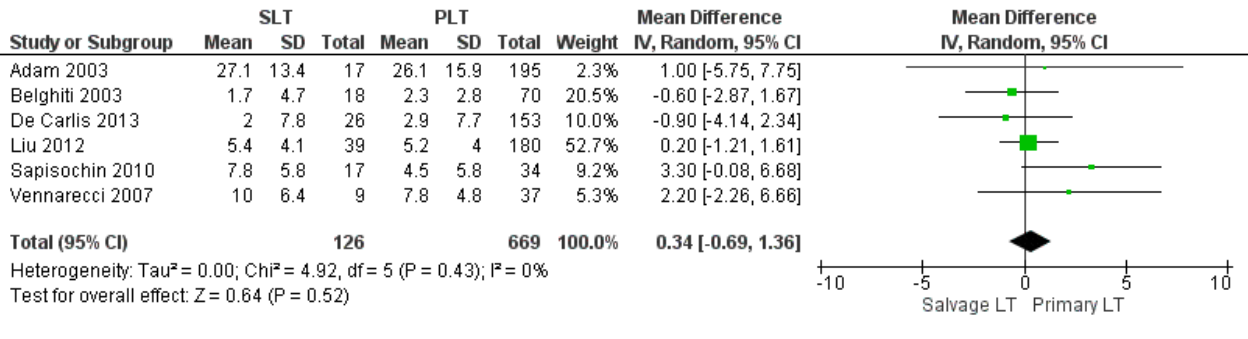
Figure 5. Fresh frozen plasma (FFP) transfusion.